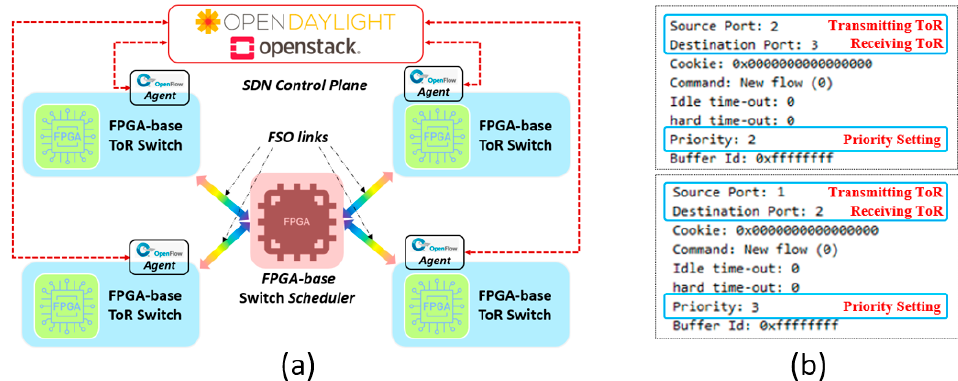
Figure 4. ( a ) The experiment setup for switch scheduling and reconfiguration; ( b ) insights from the priority configuration from the SDN-based controller.